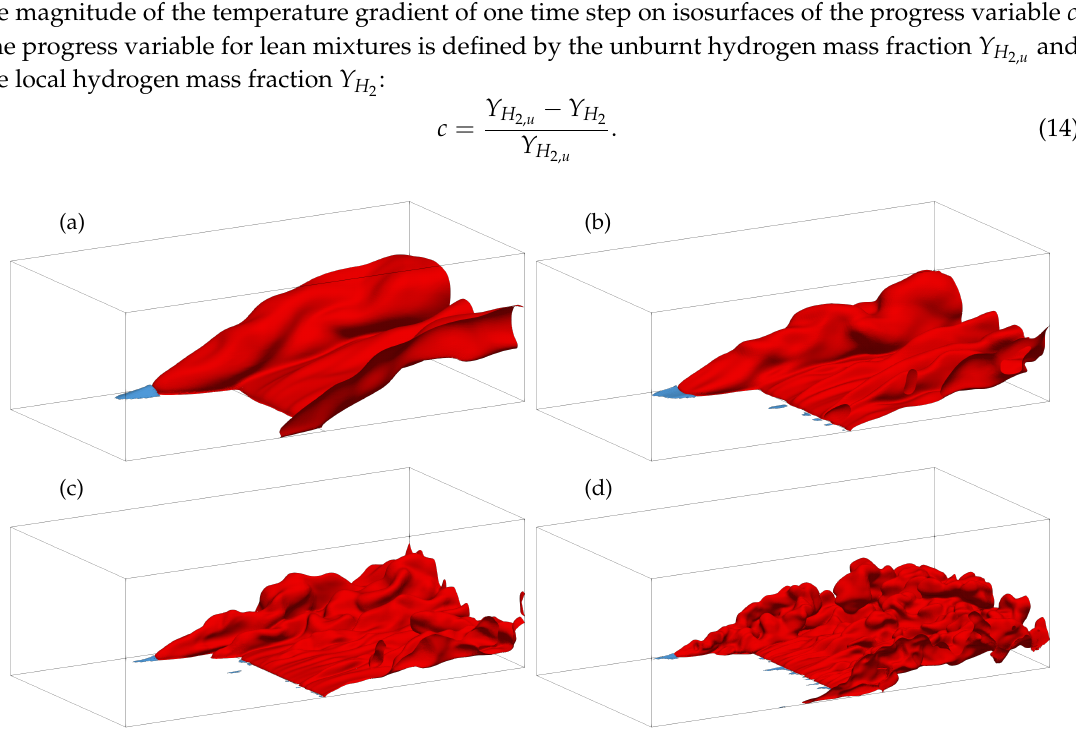
Figure 6. Instantaneous flame fronts and separation zones during flashback at the pressure levels ( a ) 0.5bar, ( b ) 1bar, ( c ) 2bar and ( d ) 3bar for U b = 10ms − 1 . The flame front is represented by the red c = 0.5 isosurface. The separation zone is represented by the blue u = 0